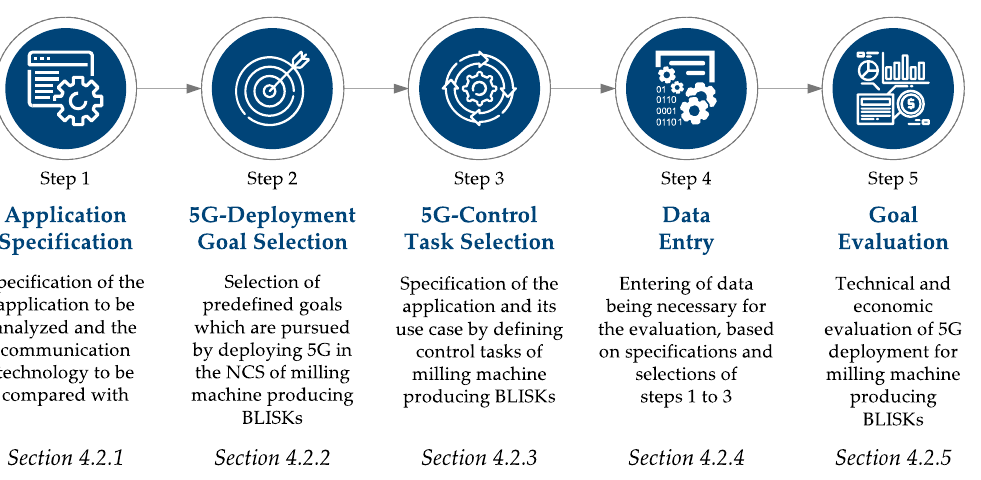
Figure 8. Section structure and evaluation approach for techno-economic evaluation of 5G technology for milling machine producing BLISKs according to [33]. for milling machine producing BLISKs according to